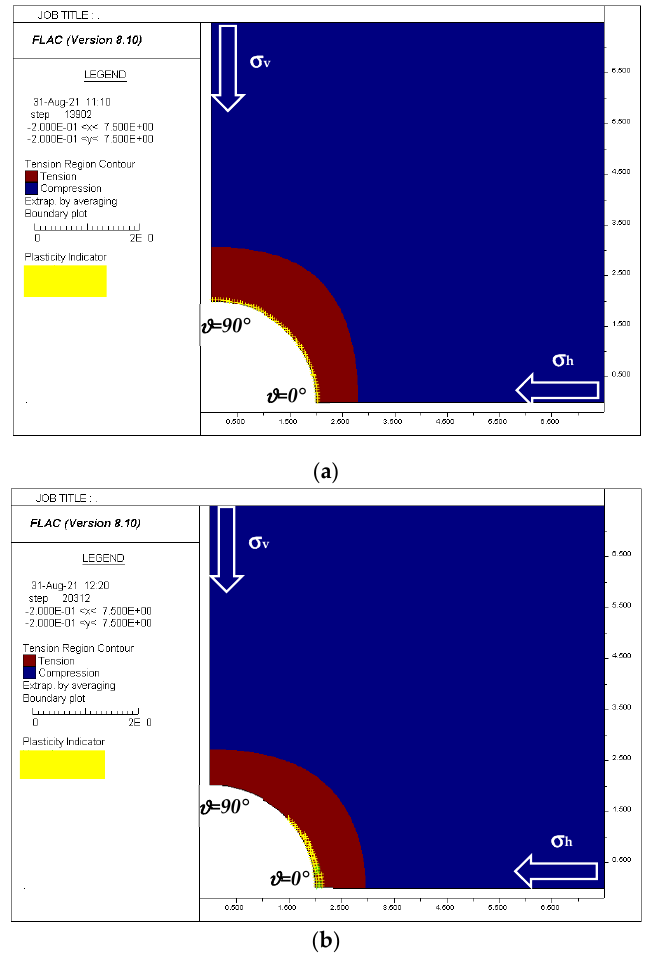
Figure 10. Undrained condition simulated with FLAC in Case 3A; ( a ) Tension zone (red) and tensile failure (yellow) calculated with Δ u = 0. The occurrence of tensile failure is obtained with u ini = 3.2 MPa, because of the numerical finite difference procedure. ( b ) Tension zone (red) and tensile failure (yellow) calculated with Δ u ≠ 0 (pore pressure shown in Figure 8b).